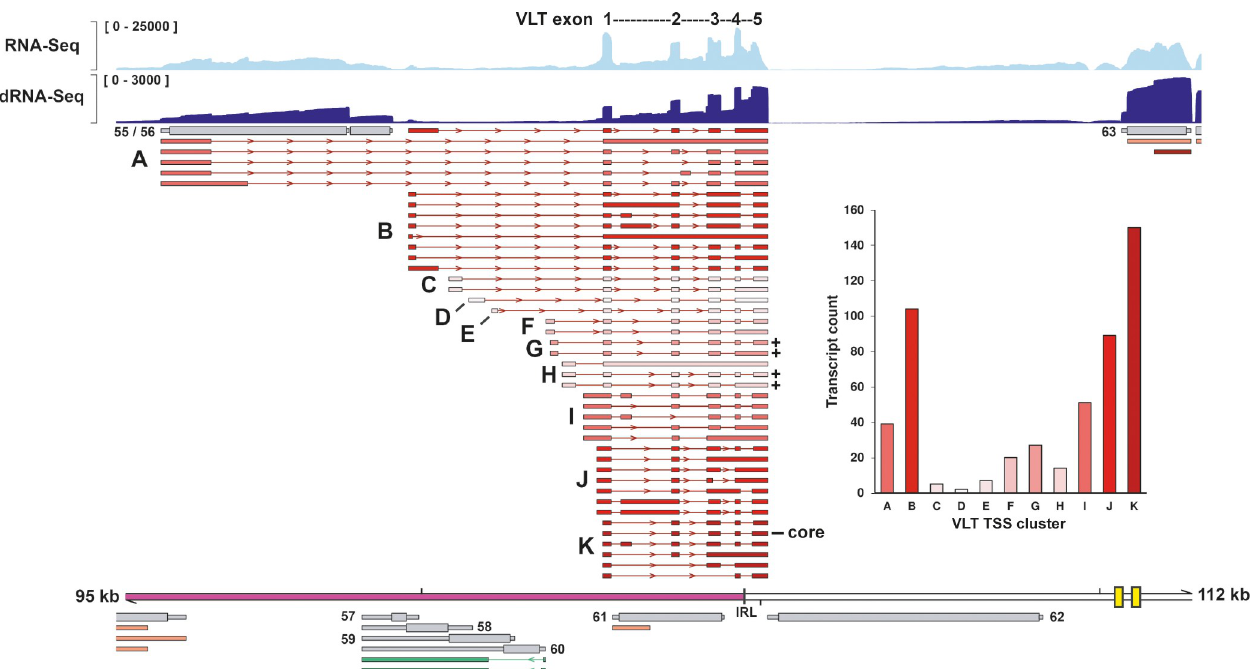
Fig 6. Structure of VLT RNA isoforms expressed during lytic SVV infection of BS-C-1 cells. VLT isoforms are given are clustered by TSS (A-K). Color gradient indicates relative abundance of transcripts originating from each TSS, and transcript counts are given in the bar graph. Counts only include reads starting within 50 bp from an annotated TSS. Coverage plots show Illumina RNA-seq (light blue) and nanopore dRNA-seq (dark blue) data. Maximum read depth per track is given on the Y-axis. Thick double black lines represent the SVV genome, ticks indicate 10 kb intervals and the reiterative repeat regions R1 to R4 and both copies of OriS are indicated as yellow boxes on the genome track. Plus signs indicate isoforms coding for the longest pVLT homologue and the core VLT is indicated.